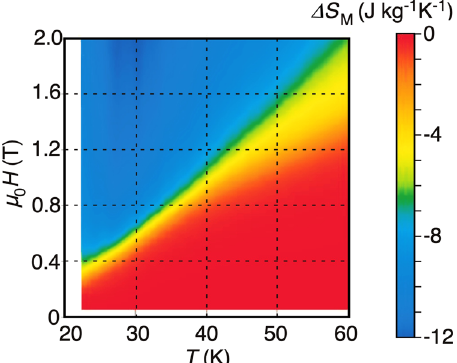
Fig. 3 Magnetic entropy change Δ S M as a function of temperature and -- magnetic fi eld along the hexagonal ½ 10 10 (cid:2) direction in holmium single crystal. The Δ S M data are estimated by Eq. (1) with an integral range from μ H = 0 T to μ H = μ H from the observed magnetization data. 0 1 0 2 0 (cid:1) hexagonal ½ 10 10 (cid:2) direction (Fig. 2). The changes are caused by the